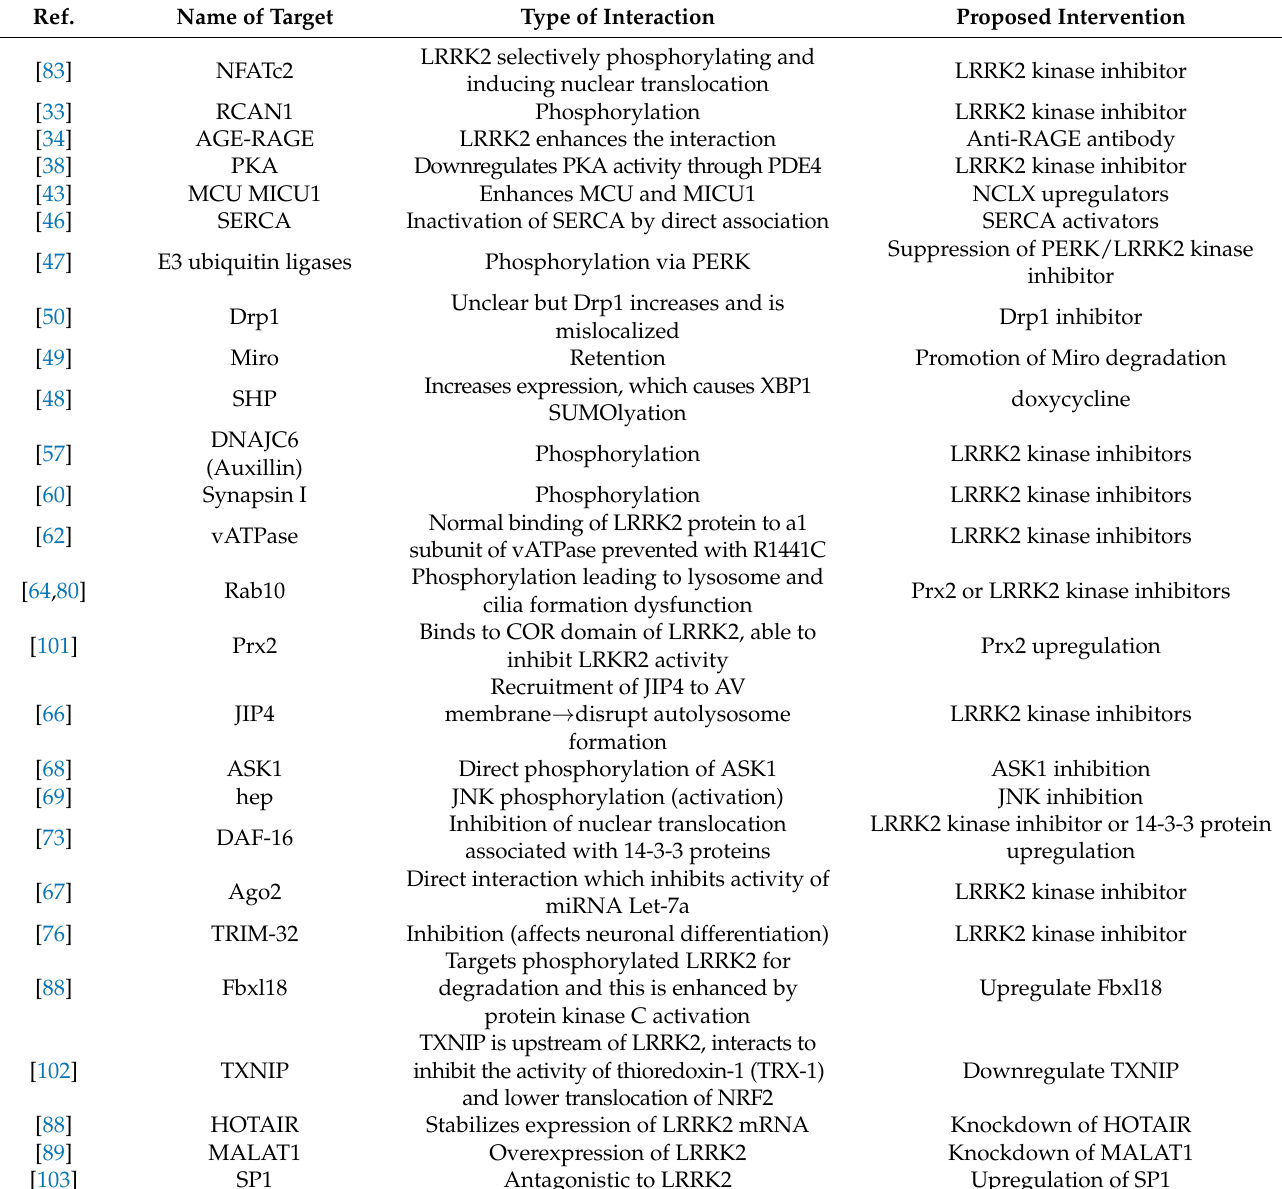
Table 15. Summary of interacting factors of LRRK2 and associated